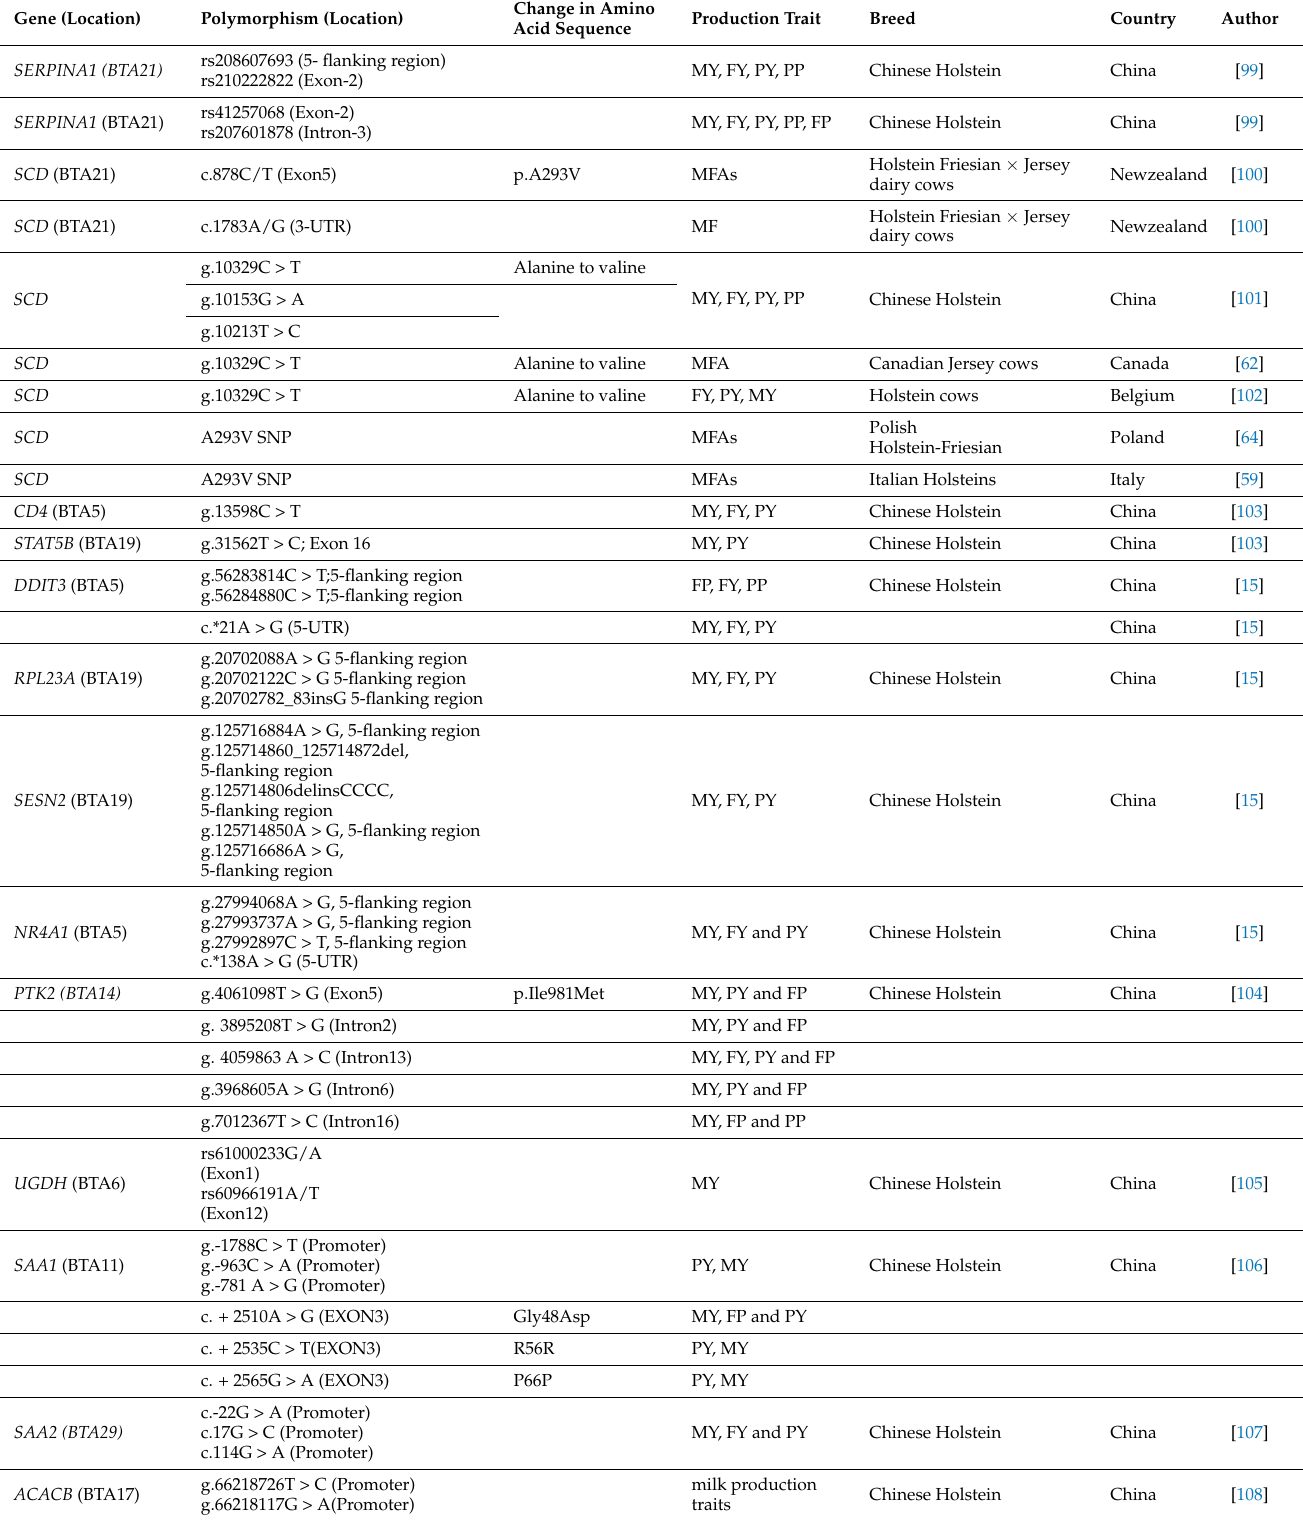
Table 3. The variations in genes and their association with milk production traits in dairy cattle. Gene